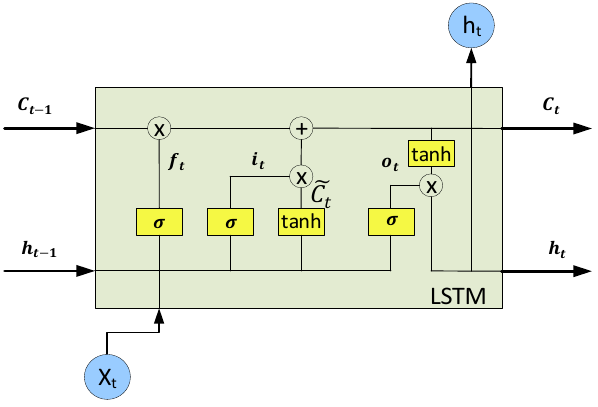
Figure 2. LSTM structure.